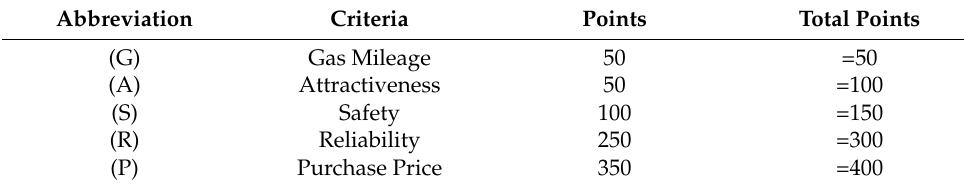
Table 4. Total points for decision